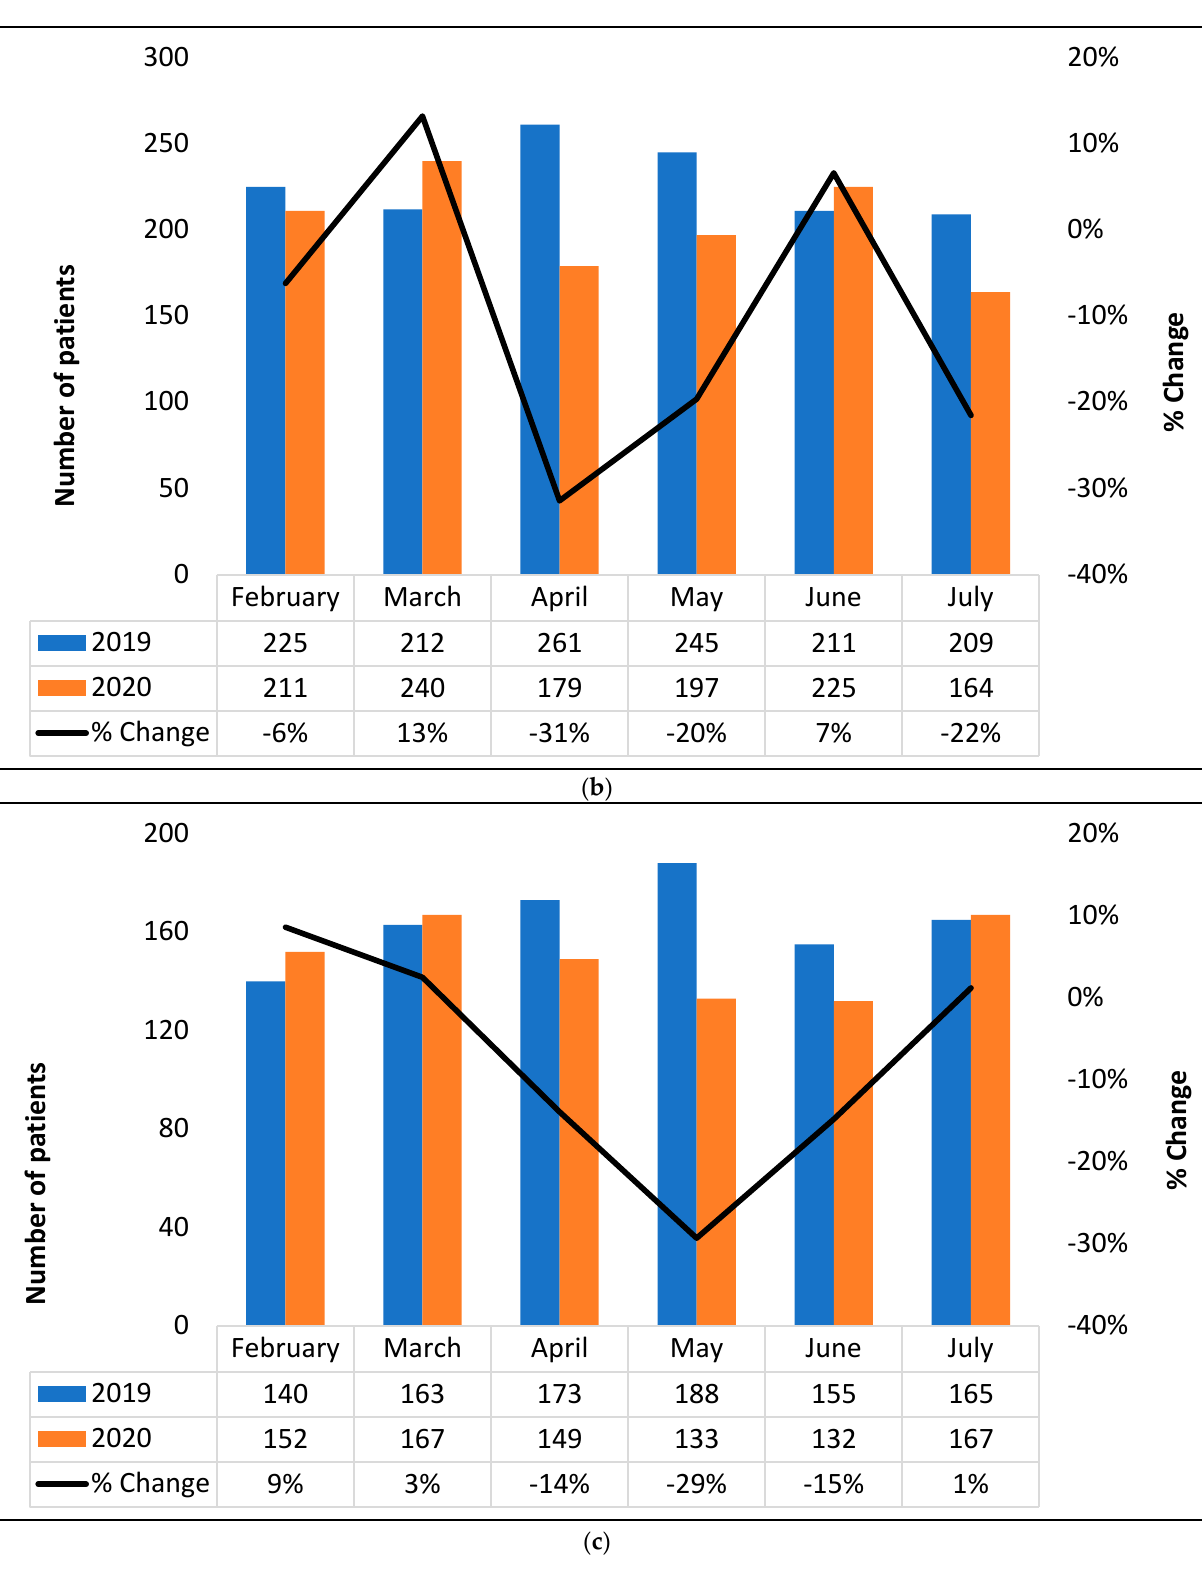
Figure 2. Effect of COVID-19 on patient encounters: comparing before and during COVID-19 ( a ) clinic/vital visits incidence ( b ) number of patients newly diagnosed with stage IV NSCLC ( c ) number of patients who initiated immunotherapy.